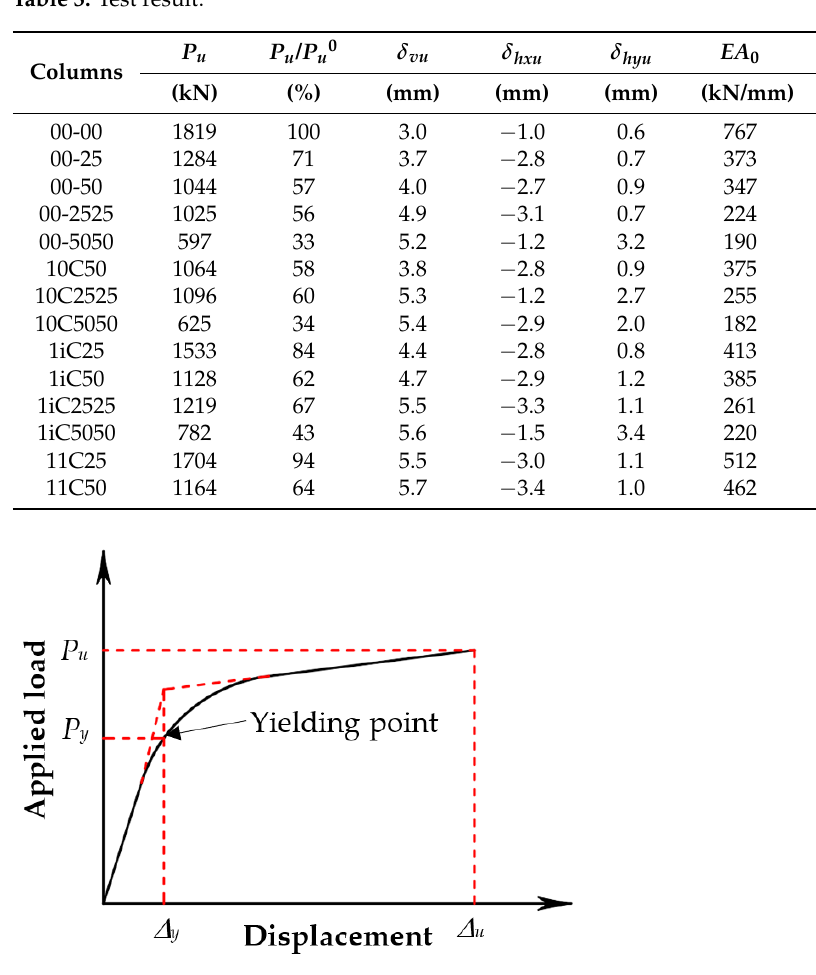
Figure 11. Strength reduction regarding e/h ratio. The increase of e/h ratio also showed a negative effect on the load-carrying capacity of the strengthened columns and the strength reduction is inversely proportional to the level of concrete confinement, e.g., unconfined, partially CFRP-confined, and fully CFRP- confined concrete. Full CFRP-wrap concrete columns increase the stiffness and ultimate displacement of the columns. Thus, the fully CFRP-confined columns experienced less strength loss than the corresponding partially CFRP-confined and unconfined concrete